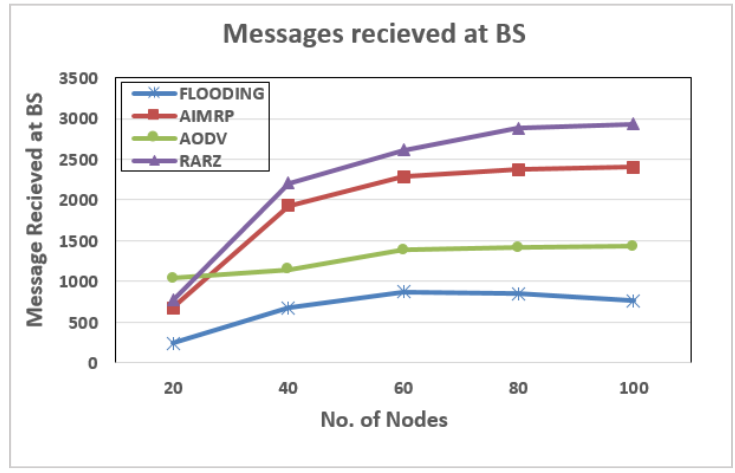
Figure 10. Number of data messages successfully received at BS against the number of nodes.